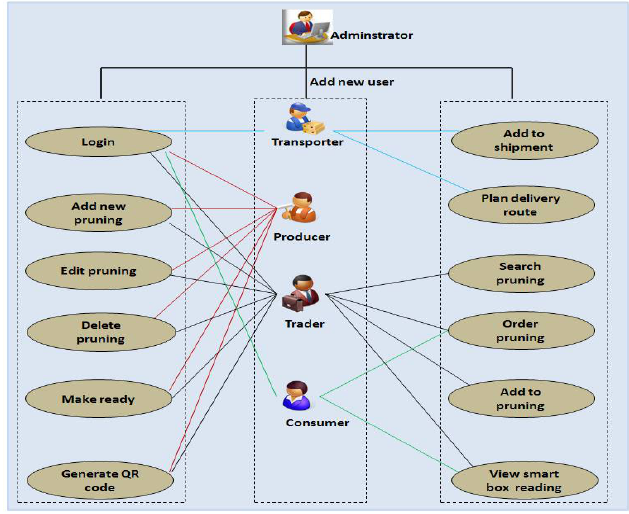
Figure 8. Network of actions by different users of the platform.